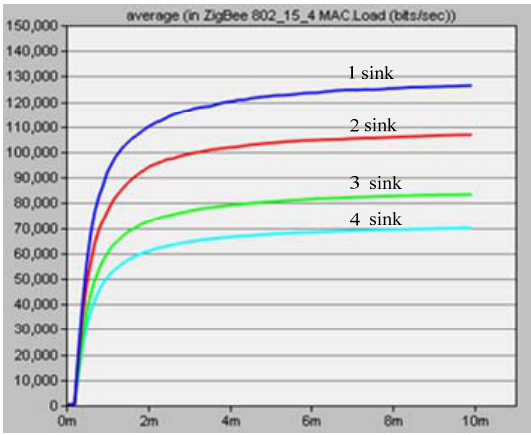
Figure 18. Network load at different sink